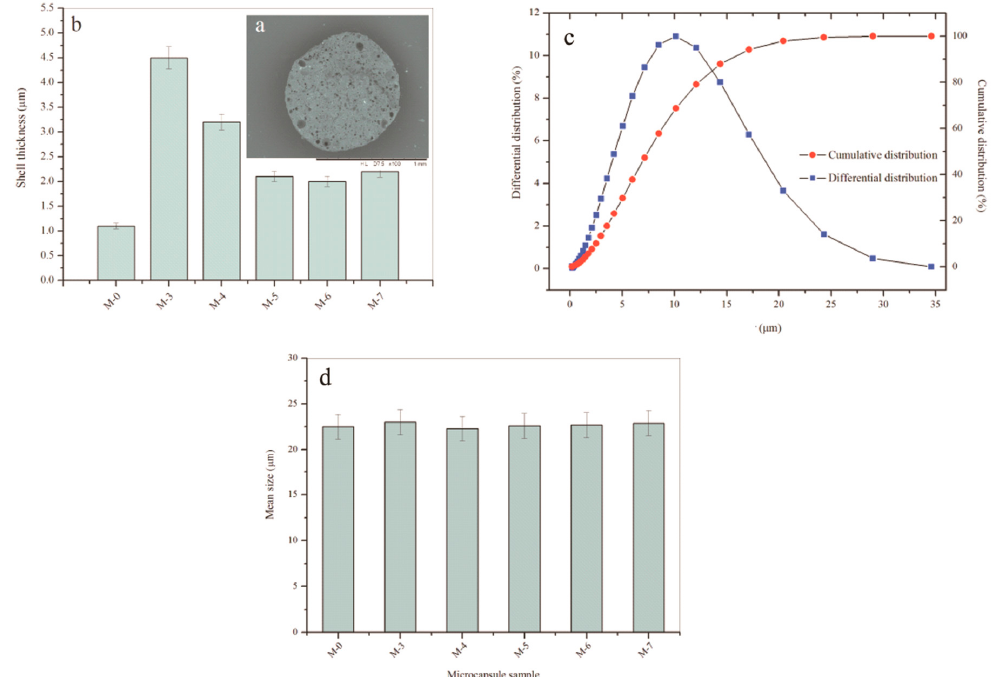
Figure 7. Geometry of the core-shell structure of microcapsule samples, ( a ) SEM morphology of cross-section of microcapsule/gelatin, ( b ) shell thickness of microcapsule samples fabricated under various pH values (M-0, M-3, M-4, M-5, M-6 and M-7), ( c ) cumulative distribution and differential distribution of microcapsule sample (M-0), and ( d ) mean size of microcapsule samples (M-0, M-3, M-4, M-5, M-6 and